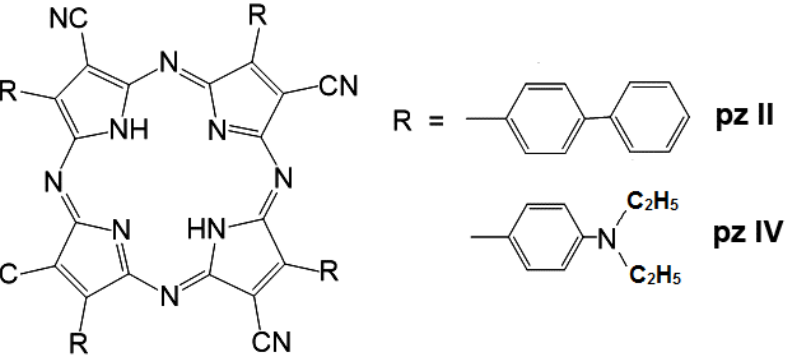
Figure 1. A chemical structure of the synthesized cyanoarylporphyrazines: pz II and pz IV . Both of the compounds demonstrated intensive light absorption, with a maximum in the red spectral region at 592–594 nm (Q-band) and a molar extinction coefficient exceeding 10 4 (Table 1). In a water solution, the fluorescence of both of the compounds was rather weak, with quantum yields of about 0.001–0.002. The fluorescence peak of pz II has a slight bathochromic shift compared to pz IV due to the extension of the π -conjugated aromatic system (Table 1). Table 1. Photophysical properties of pz II and pz IV in a water solution.